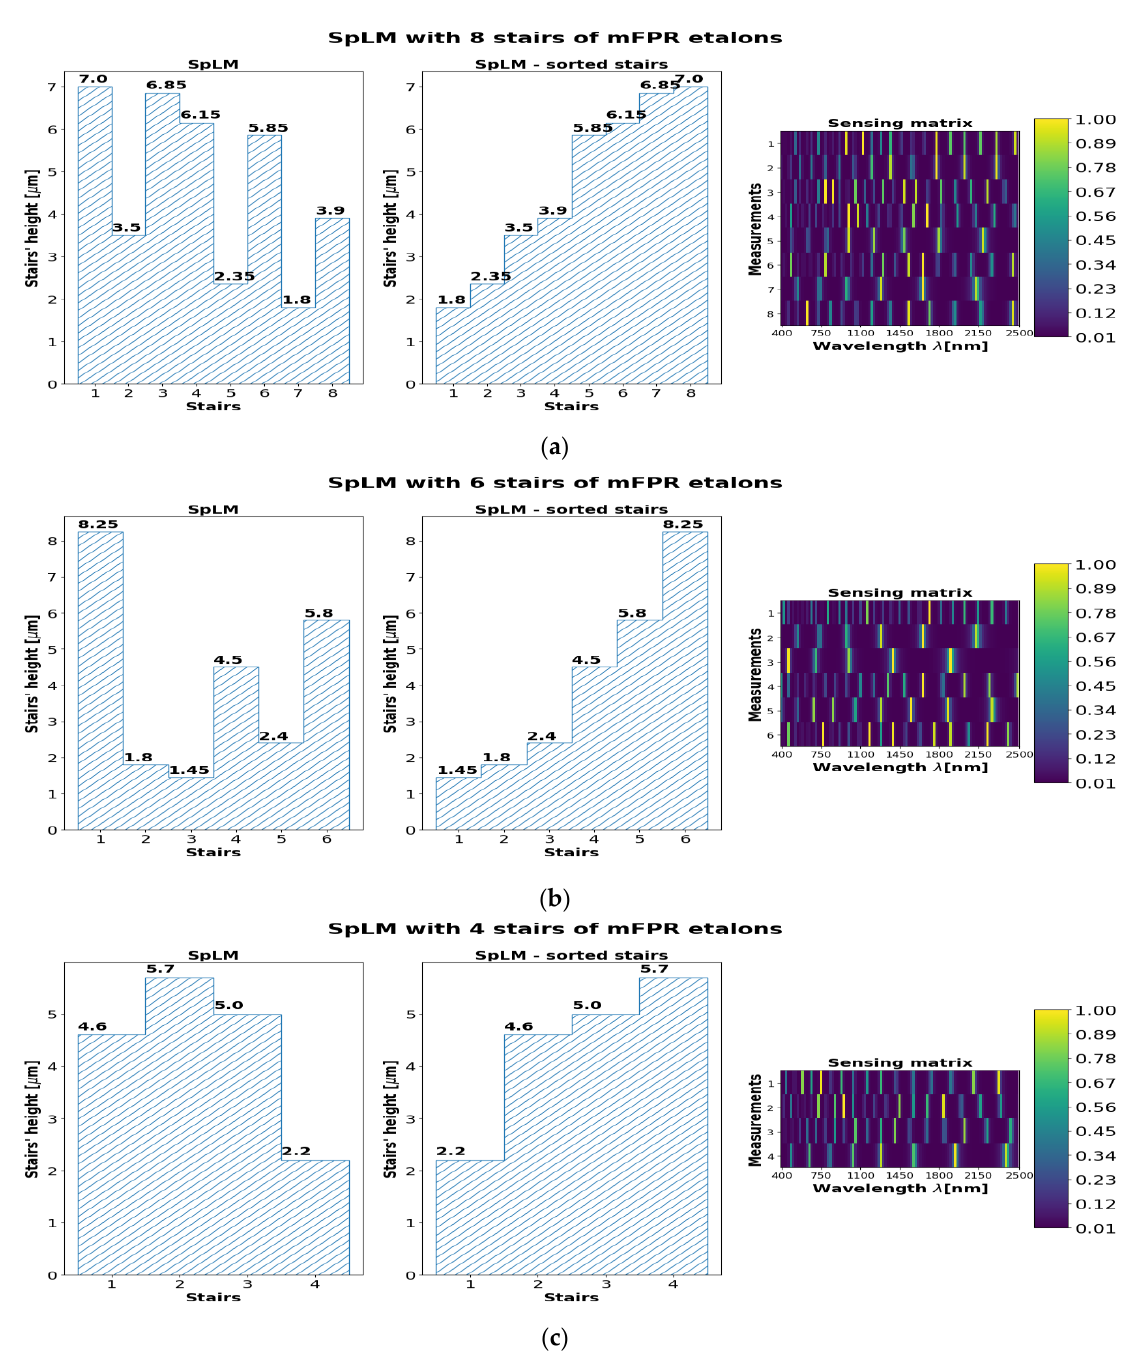
Figure 7. Three configurations of SpLMs were obtained by training the PyCAE on “Pavia center” data: ( a ) SpLM with 8 stairs, ( b ) SpLM with 6 stairs, and ( c ) SpLM with 4 stairs. The stairs height of the SpLMs as obtained from the learning process are shown on the left-hand side. The respective sensing matrices are shown on the right-hand map. The center image shows the preferable reordering of the stairs to obtain a staircase as in Figure